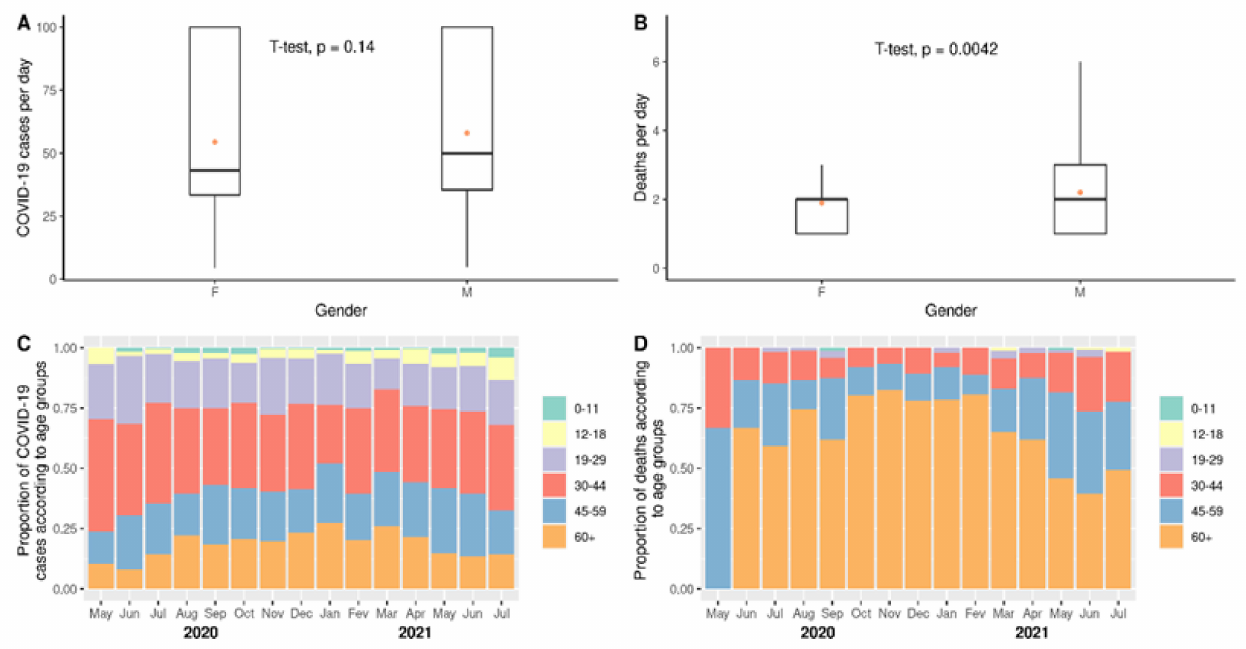
Figure 2. Impact of COVID-19 according to gender or age. Comparisons of numbers of cases per day ( A ) and numbers of deaths per day ( B ) considering the whole period of study were carried out based on Student’s t -test. Significance was set as p ≤ 0.05. In addition, proportions of cases ( C ) and deaths ( D ) according to age groups were computed. Dots represent means. Horizontal bars represent